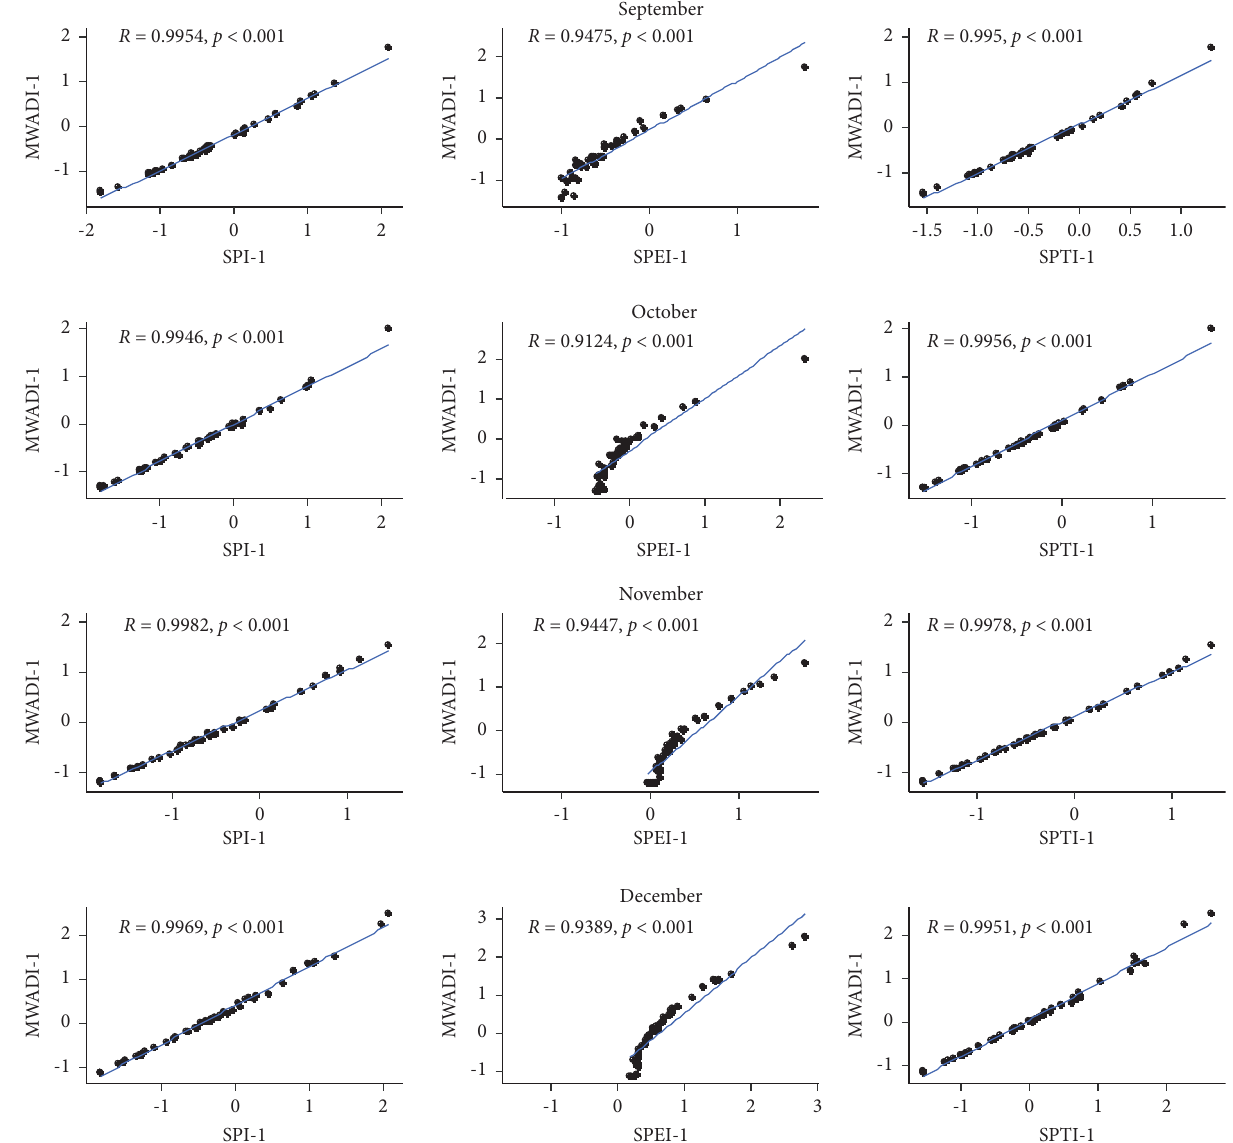
Figure 6: Te scatter diagram and correlation coefcient R values between the seasonal MWADI and the SPI, the SPEI, and the SPTI (September–December) at